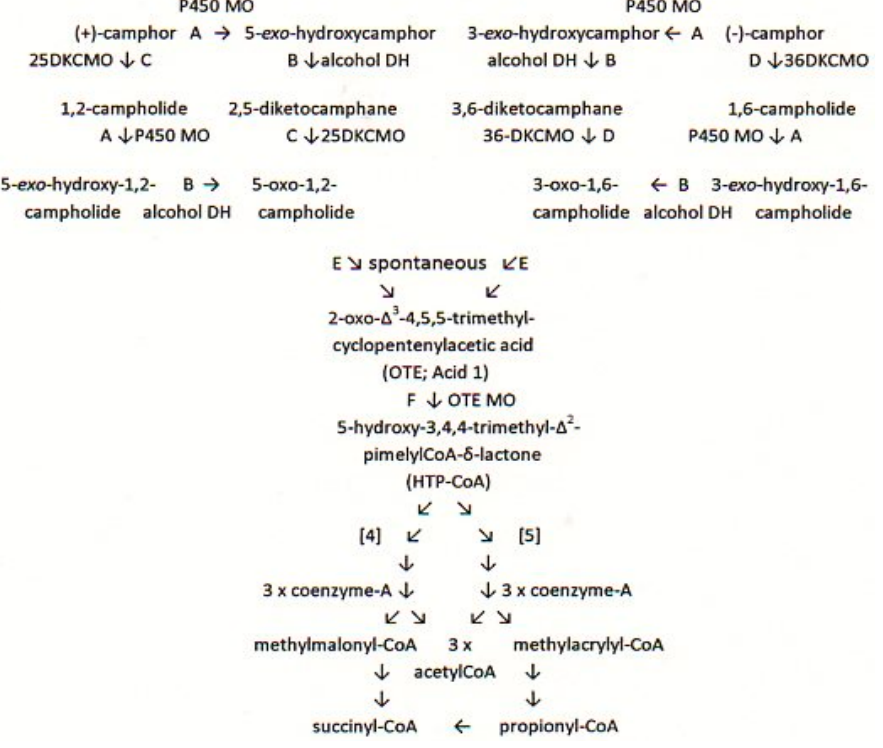
Figure 1. Pathway(s) of (+)- and ( − )-camphor degradation in P. putida NCIMB 10007. A = cytochrome P450 monooxygenase ( camA + camB + camC ); B = exo -hydroxycamphor dehydrogenase ( camD ); C = 2,5-diketocamphane 1,2-monooxygenase ( camE 25-1 + camE 25-2 ); D = 3,6-diketocamphane 1,6-monooxygenase ( camE 36 ); E = spontaneous; F = OTE monooxygenase ( camG ). The early steps